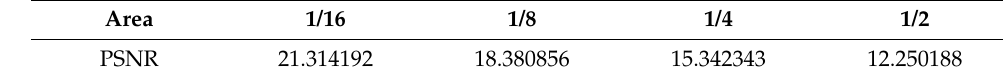
Table 6. PSNR of different degrees of clipping attack.